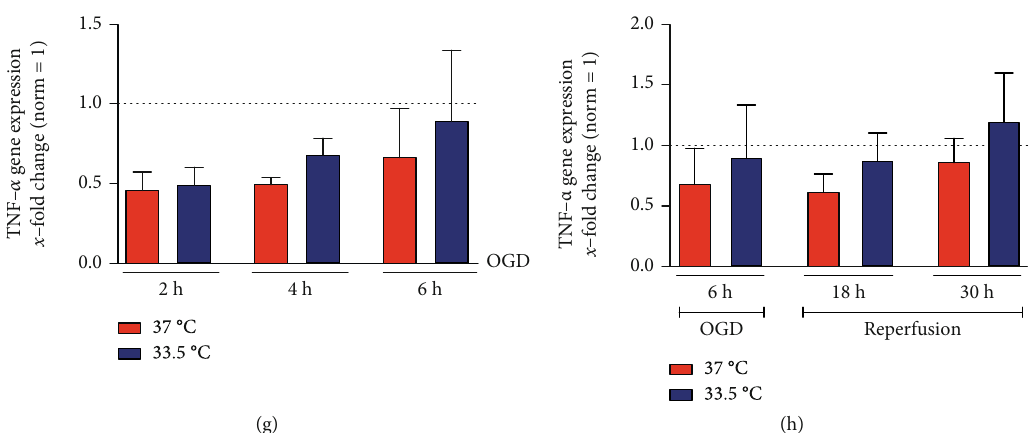
Figure 3: RT-qPCR gene expression analysis of OGD/R-induced innate immune response of (a, b) iNOS in fl ammatory enzyme and proin fl ammatory cytokines (c, d) IL-1 β , (e, f) IL-6, and (g, h) TNF- α in murine cardiomyocytes after exposure to 2, 4, and 6 hours OGD followed by 12 and 24 hours reperfusion (18 hours and 30 hours after experimental start, respectively) at 37 ° C and 33.5 ° C. Data from at least 3 independent experiments are shown as mean ± SD . Statistical analysis was performed using one-way ANOVA with Tukey posttest; # p < 0 : 05 as compared to 37 ° C normoxia control group and ∗ p < 0 : 05 comparison between the two experimental groups were considered signi fi